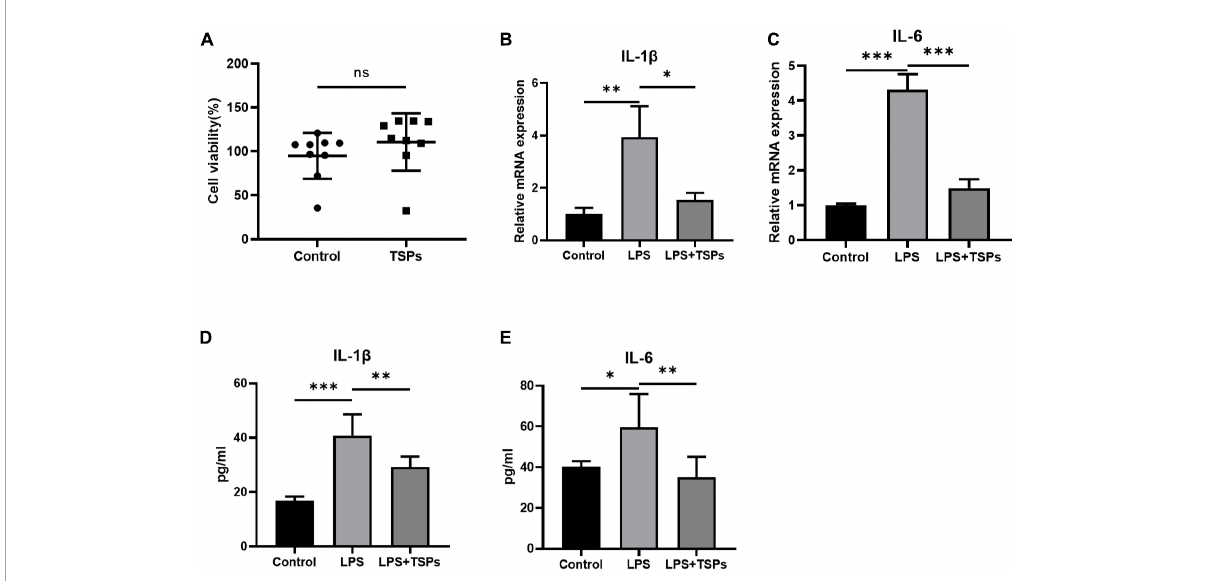
FIGURE1 The cell viability and expression of pro-inflammatory cytokines of mice colonic epithelial cell line CT-26. (A) Cell viability was determined by CCK-8 assay after TSPs treatment ( n = 9). (B,C) Relative mRNA expression of two pro-inflammatory cytokines, IL-1 β and IL-6 ( n = 3). The concentrations of IL-1 β (D) , IL-6 (E) measured by ELISA ( n ≥ 5). Data were presented as means ± SD. Statistical significance was determined using Student’s t -test or one-way ANOVA. ∗ P < 0.05, ∗∗ P < 0.01, ∗∗∗ P < 0.001; ns, no